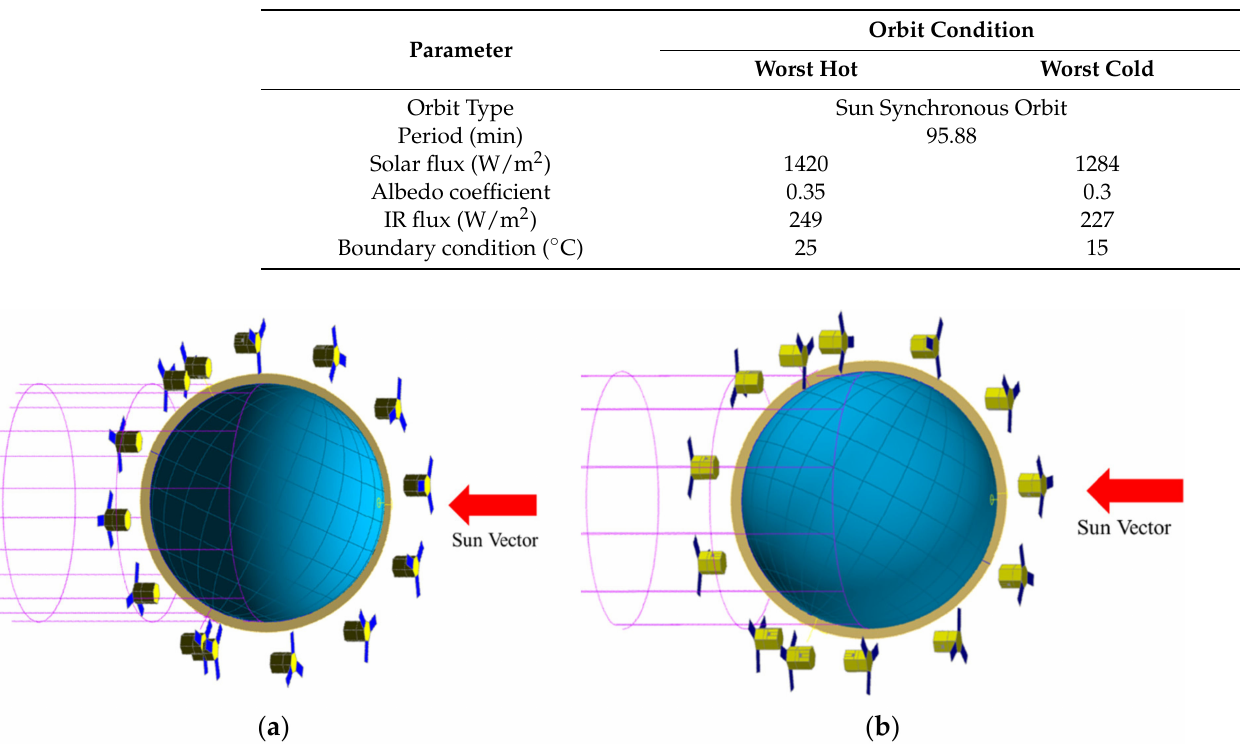
Figure 5. In-orbit profile of BB. ( a ) Worst hot case; ( b ) worst cold